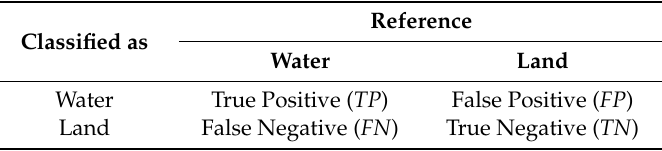
Table 3. Confusion matrix